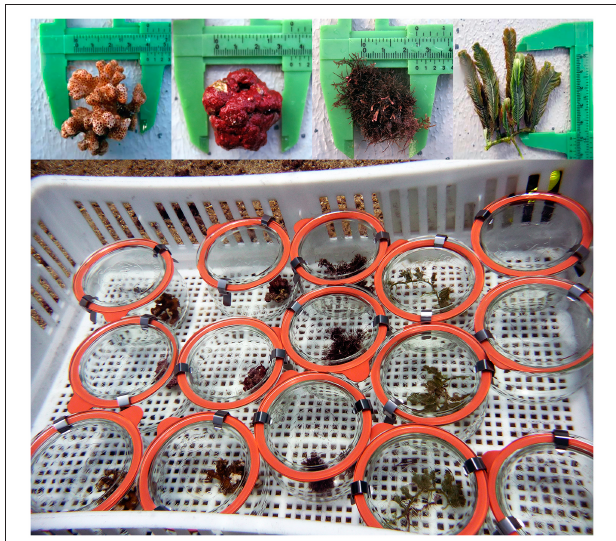
FIGURE 2 | Dominant primary producers and incubation set-up. The upper panel shows the incubated organisms Pocillopora spp., crustose coralline algae, turf algae and Caulerpa sertularioides (from left to right). The lower picture shows the incubation set-up in 5m water depth on the seafloor.